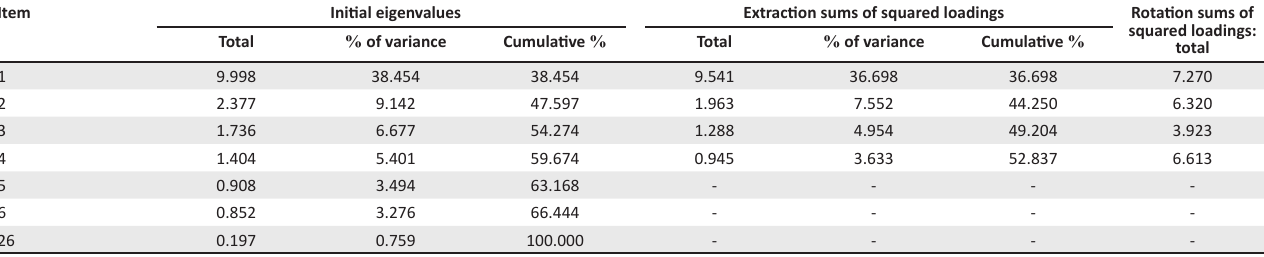
TABLE 4: Total variance explained after dropping items with low factor coefficients: Total variance explained. Factor number Initial eigenvalues Extraction sums of squared loadings Rotation sums of TotalTotal % of variance Cumulative % Total % of variance Cumulative